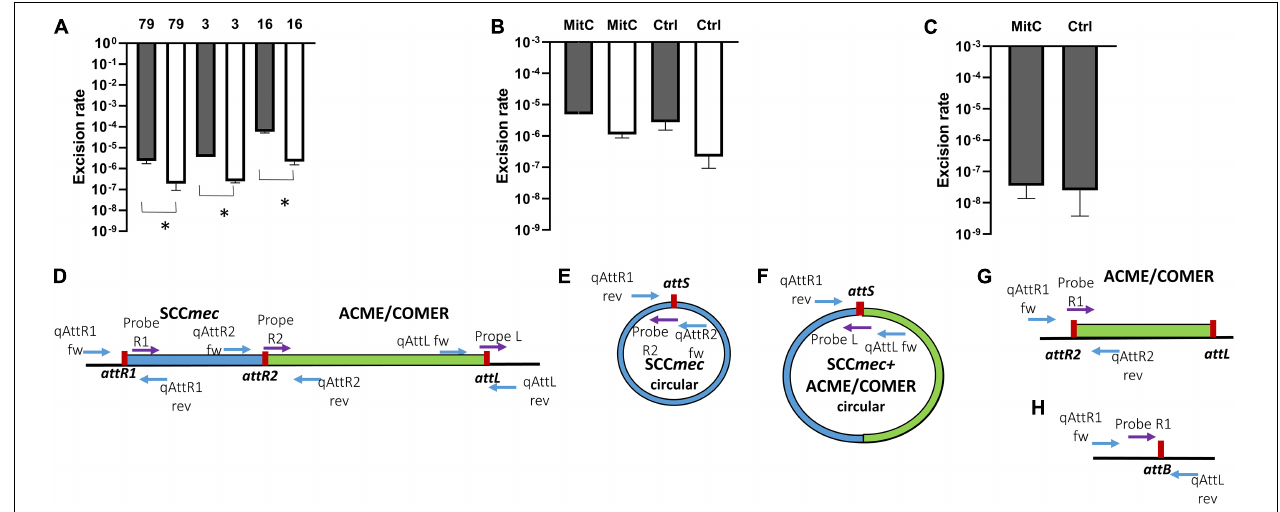
FIGURE 6 | Excision rates of composite SCC mec elements. The rate of excision was measured using real-time qPCR by comparing the excised circularized element and the reconstituted chromosomal attachment site to the integrated element using this formula: 2 − (cid:49) CT . The columns represent the rate of excised element, SCC mec alone (gray) and the composite SCC mec /ACME (white), in isolates STAPH79, STAPH3, and STAPH16. Error bars represent the mean SD of the excised element with and without mitomycin C, asterisk (*) indicates p -value smaller than 0.05 ( p < 0.05). (A) Induction with mitomycin C did not affect the excision ratio of the SCC mec (gray) nor the composite SCC mec /ACME (white) in isolate STAPH79 comparing to the control (Ctrl) (B) . In STAPH60, like in STAPH79, the mitomycin C induction had no effect on excision frequency with respect to control (Ctrl) (C) . The schematic representation of the excision of SCC mec and ACME/COMER-like elements is shown in (D–H) including the chromosome containing the integrated SCC mec (blue) with the ACME/COMER elements (green) (D) , the circular form of the SCC mec (E) and circular form SCC mec with ACME/COMER-like element (F) , the chromosome with the ACME/COMER element after excision of SCC mec only (G) and the reconstituted chromosome after excision of the whole composite element (H) . The att sites are shown in red and the primers used for qPCR are shown as blue arrows and TaqMan probes as purple arrows. The maps are not drawn to